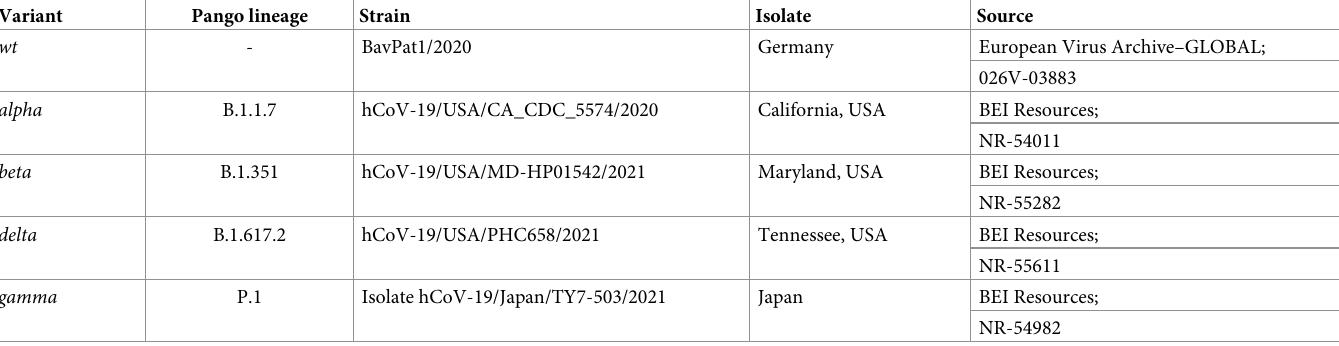
Table 1. SARS-CoV-2 variants used in ViroSpot reduction and plaque assays to evaluate antiviral properties of stenoparib and remdesivir.